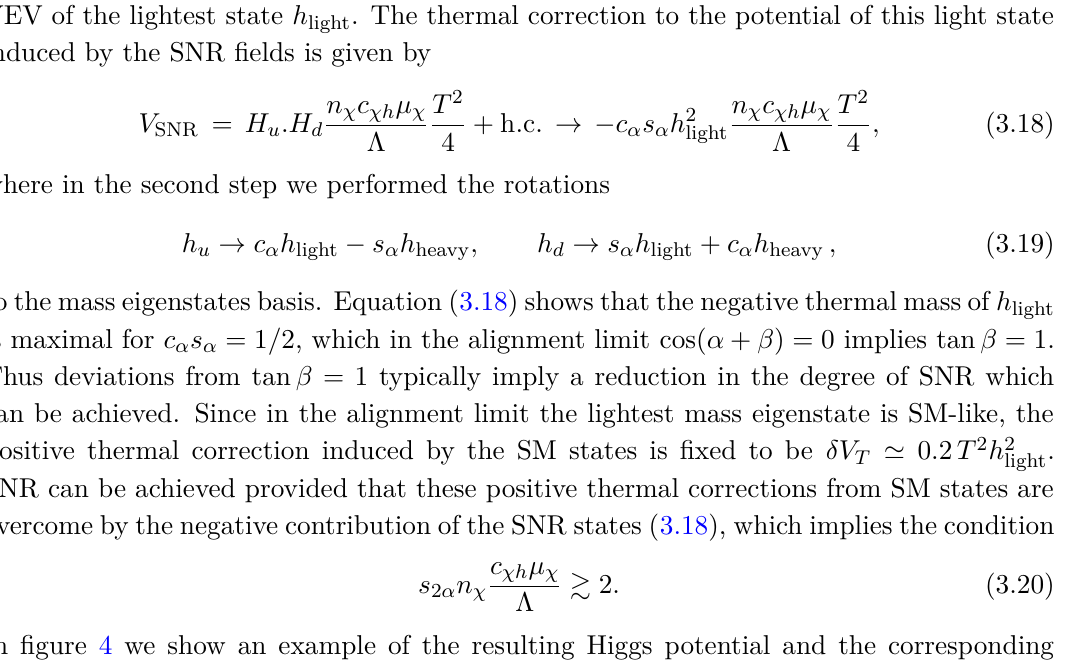
= 2 TeV. Right panel: the + ,H A p h 2 + h 2 evolution with u d